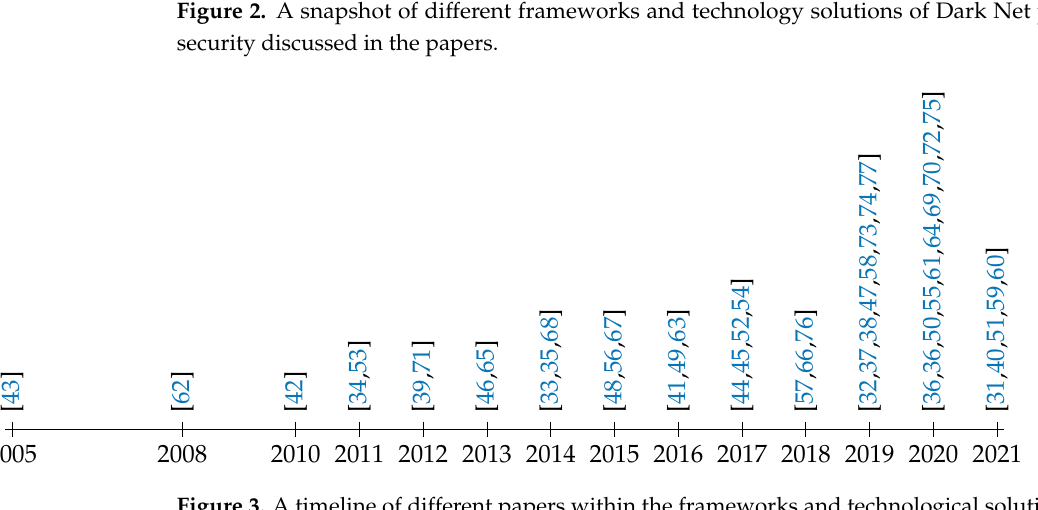
Figure 3. A timeline of different papers within the frameworks and technological solutions